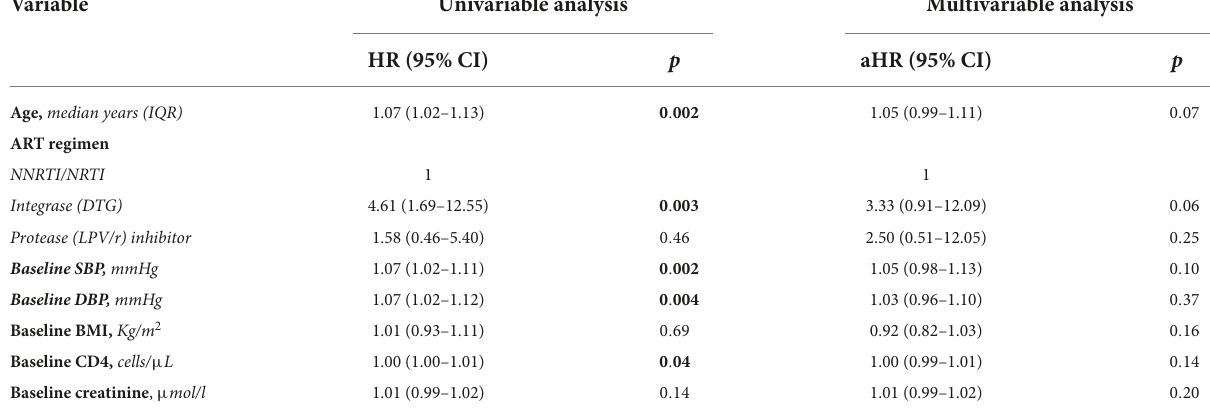
TABLE 4 Predictors of incident hypertension in females with